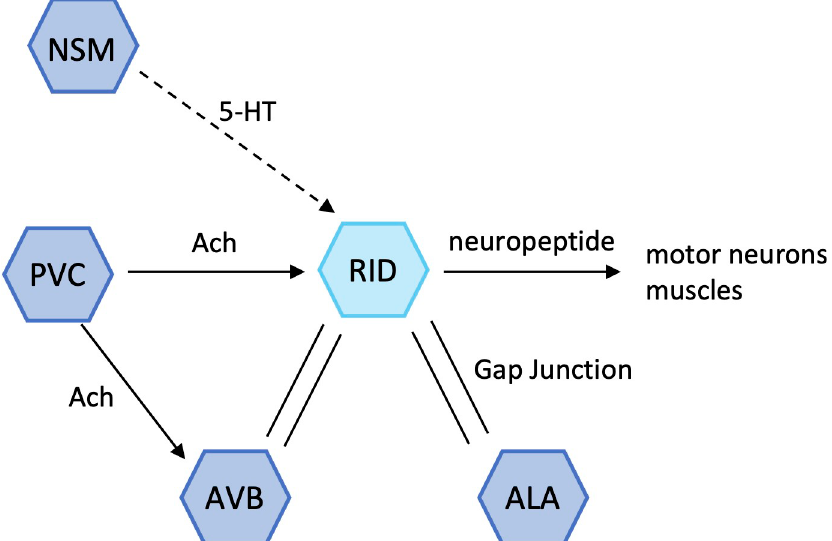
Fig 4. Schematic model of the RID and other neurons around the RID. The PVC is a command interneuron for forward locomotion, modulating the behavioral response to harsh touch. The AVB is also a command interneuron for forward locomotion. The ALA is involved in normal quiescence and a high-threshold mechanosensation. Finally, the NSM senses bacteria, secretes serotonin, and modulates the enhanced slowing response.